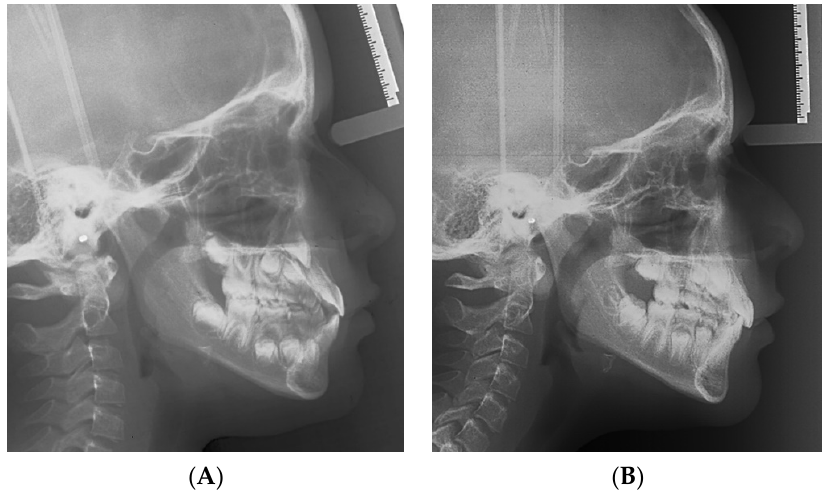
Figure 3. Pretreatment ( A ) and posttreatment ( B ) lateral cephalogram. Table 1. Cephalometric analysis.